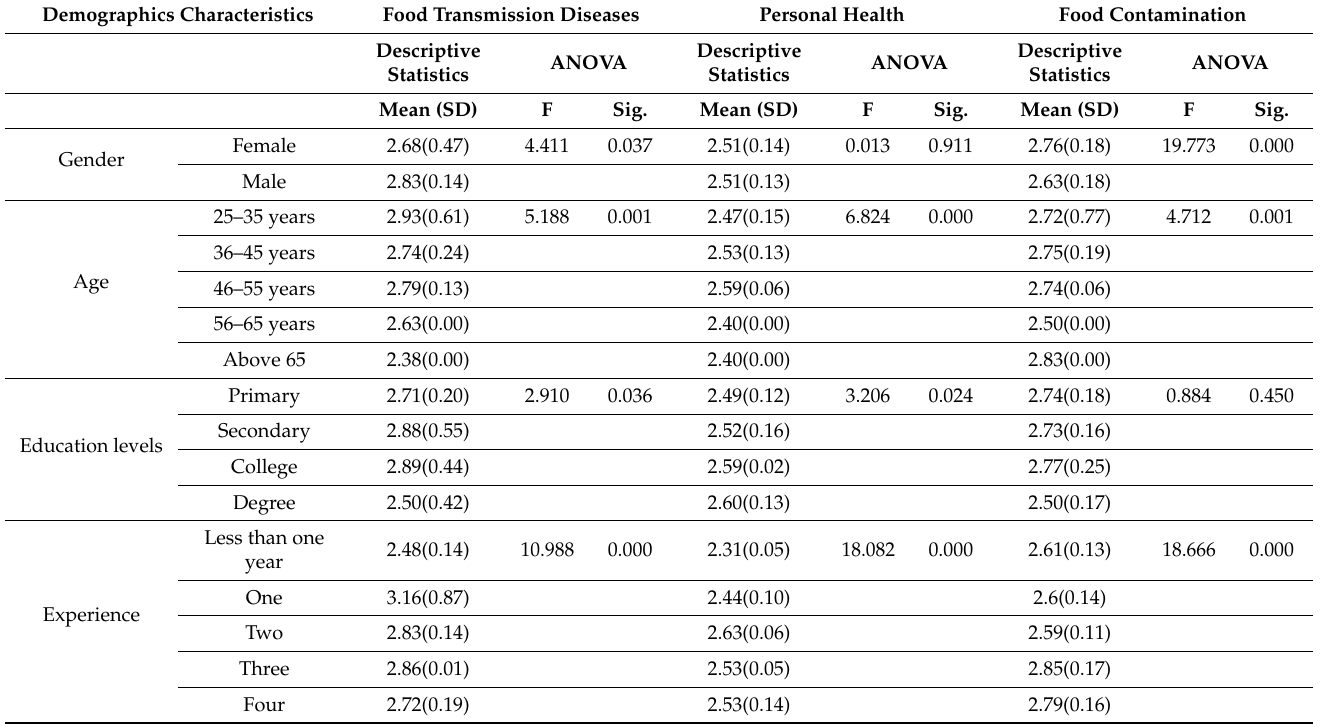
Table 6. Demographic characteristics and level of food knowledge of food handlers in Kenyan high school kitchens. Demographics